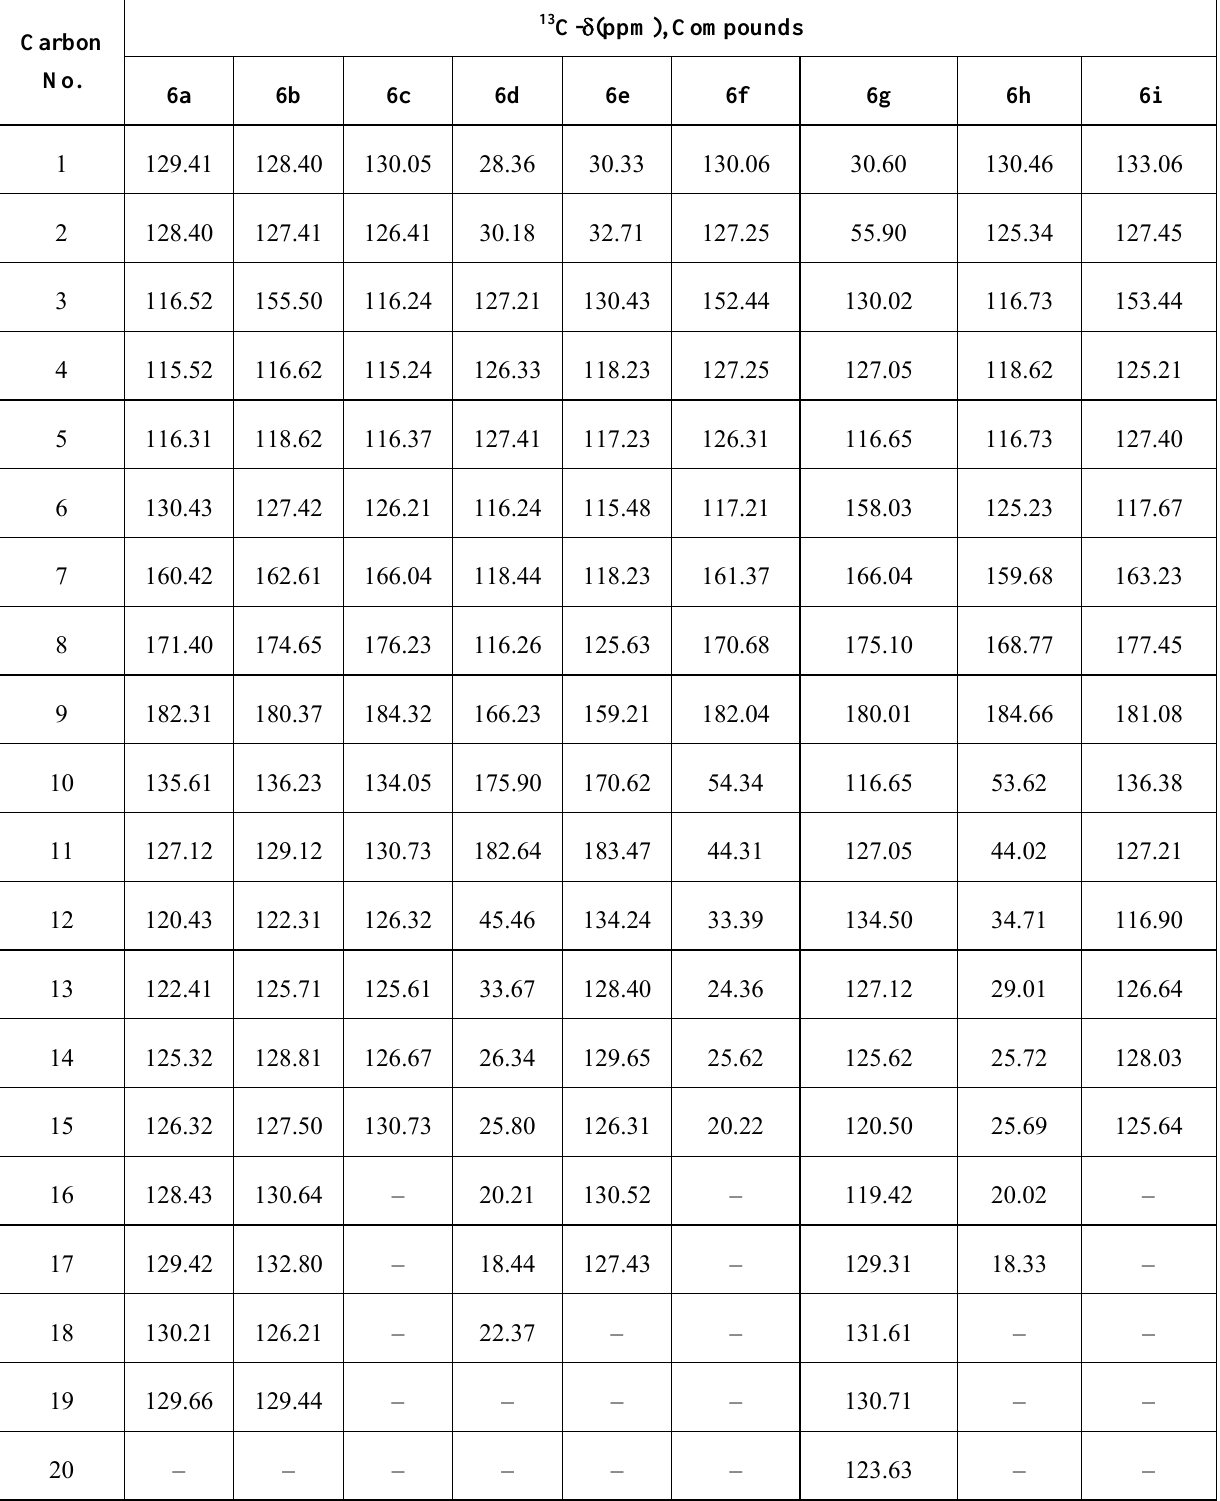
Table 2. 13 C-NMR spectral data of 5-substitued-4-amino-1,2,4-triazole-3-thioesters 6a-i .